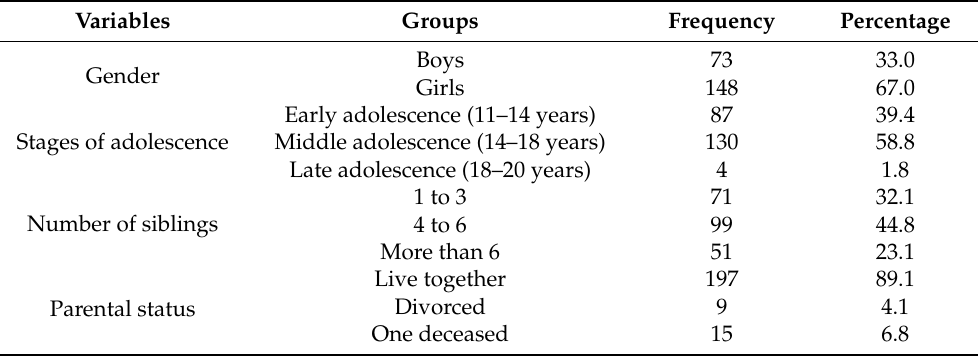
Table 1. Participant